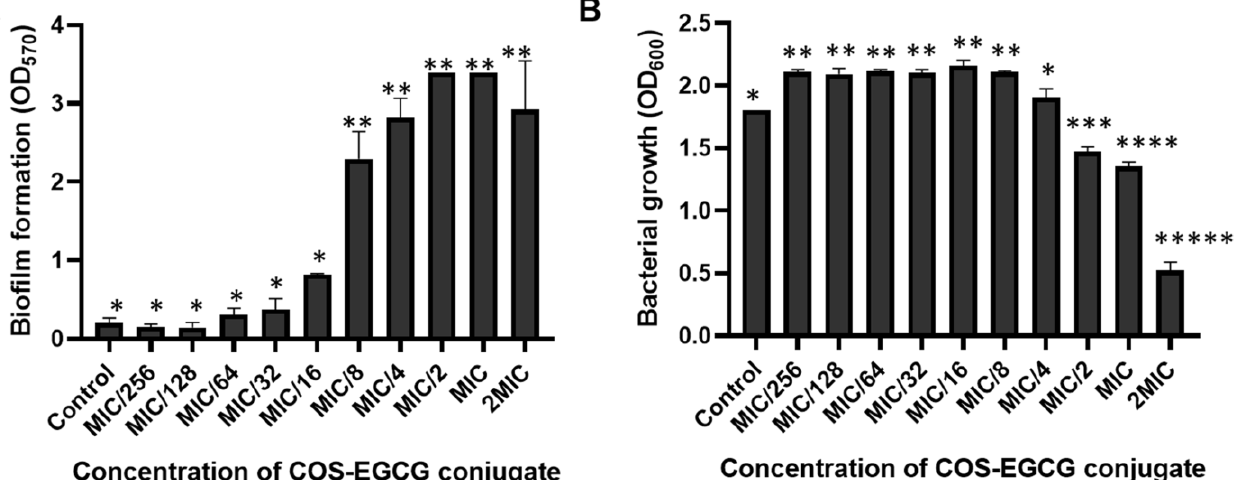
Figure 2. Biofilm formation ( A ) and the growth ( B ) of L. monocytogenes after treatment with COS- EGCG conjugate at different concentrations, as well as the control with 0.01% acetic acid in the TSB medium. The different asterisks on the bars denote significant differences ( p < 0.05). The results are presented as means ± SD ( n = 3) .